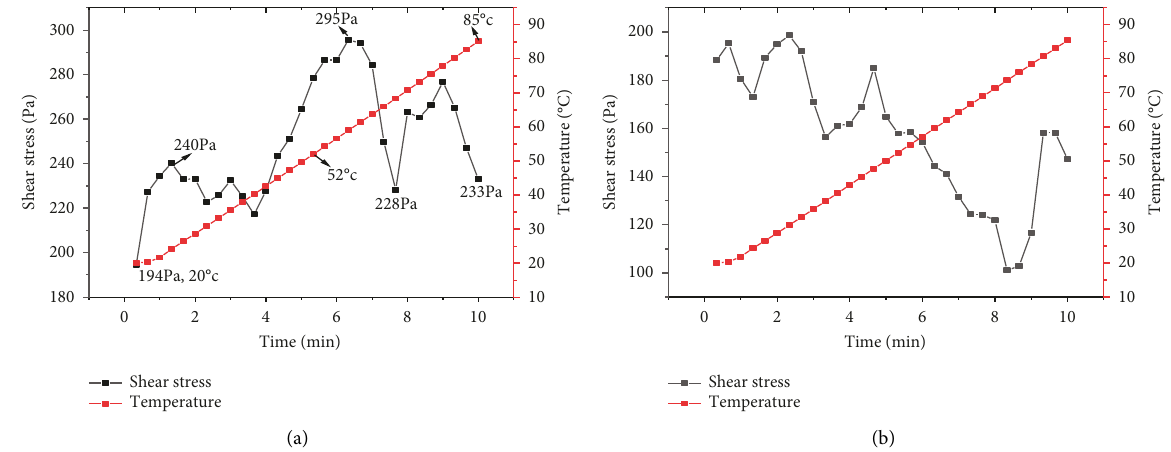
Figure 2: Rheological properties of (a) avocado starch and (b) starch-cellulosic blend.